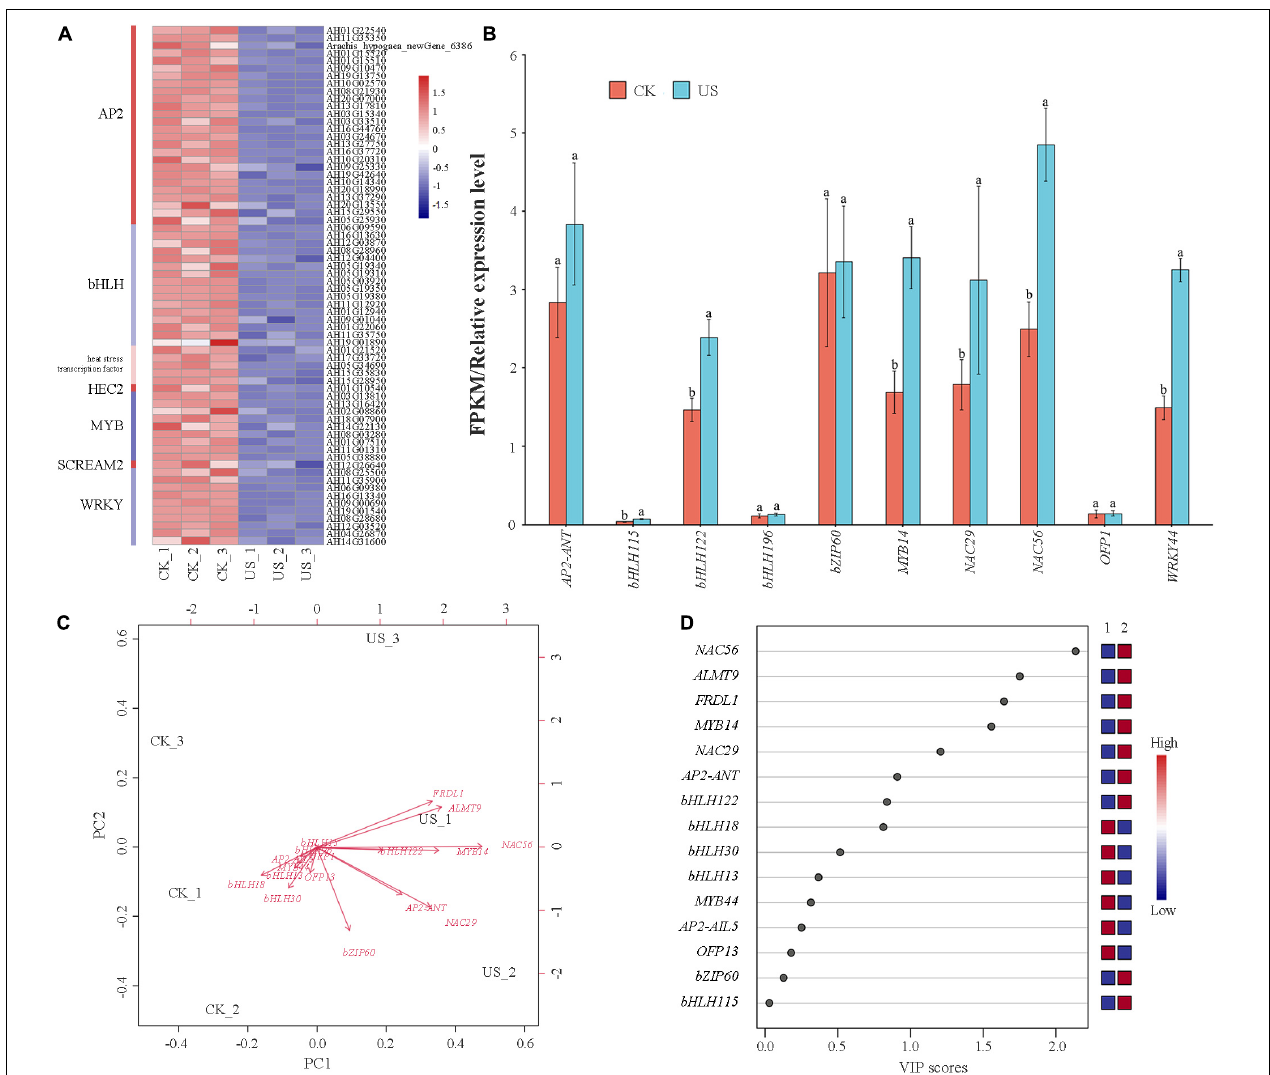
FIGURE 7 | Heatmap of known 33 transcription factors (TFs). (A) Red color indicates downregulation, and blue color indicates upregulation. (B) Comparison of the FPKM value obtained using RNA-seq analysis with the gene expression obtained using quantitative real-time (qRT)-PCR analysis. (C) Principal component analysis (PCA). (D) Partial least squares discriminant analysis